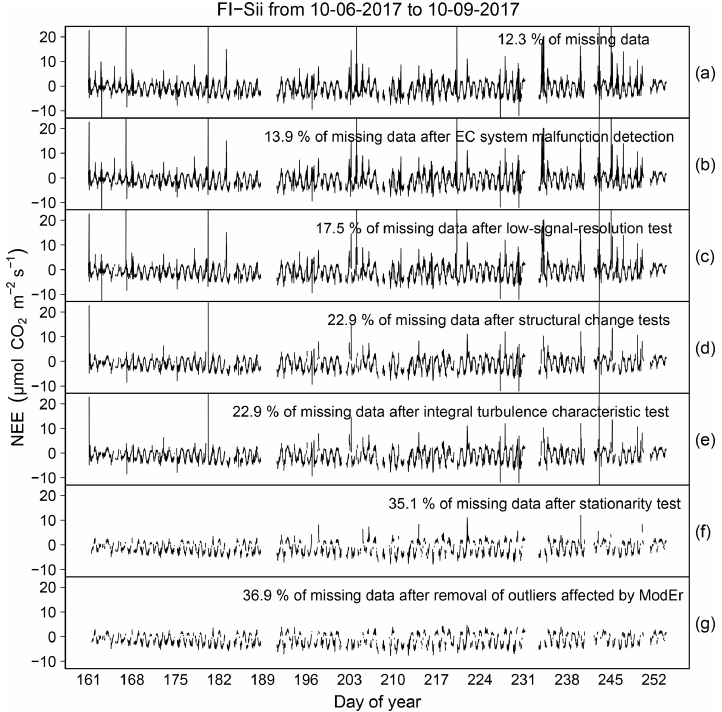
Figure 11. Illustrative example of the sequential data cleaning procedure applied to NEE fluxes at the FI-Sii site.